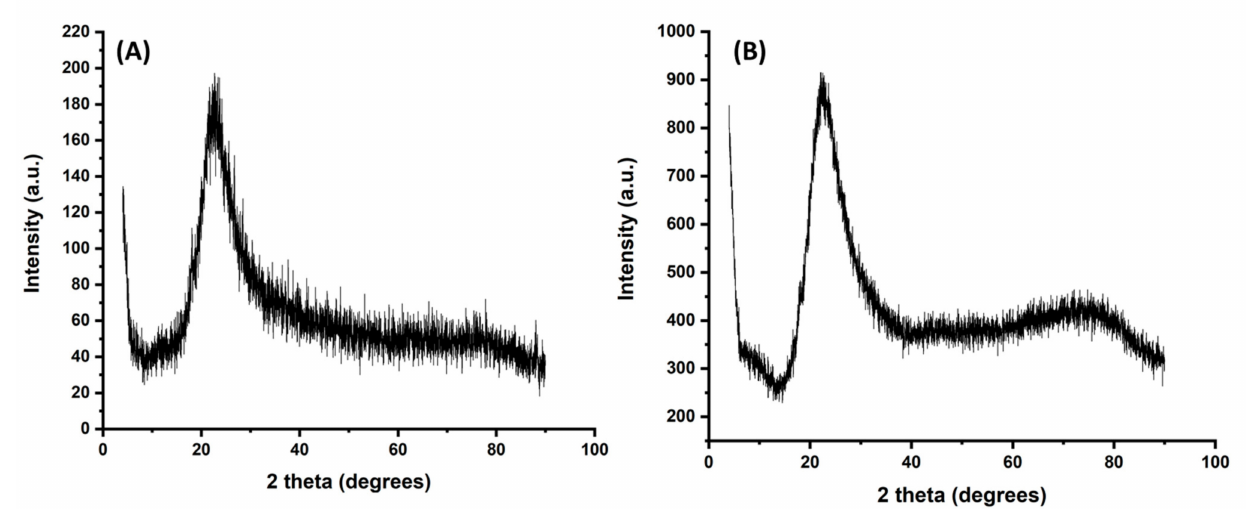
Figure 2. X-ray diffraction (XRD) patterns of ( A ) ACT-MIP, ( B ) NIP.